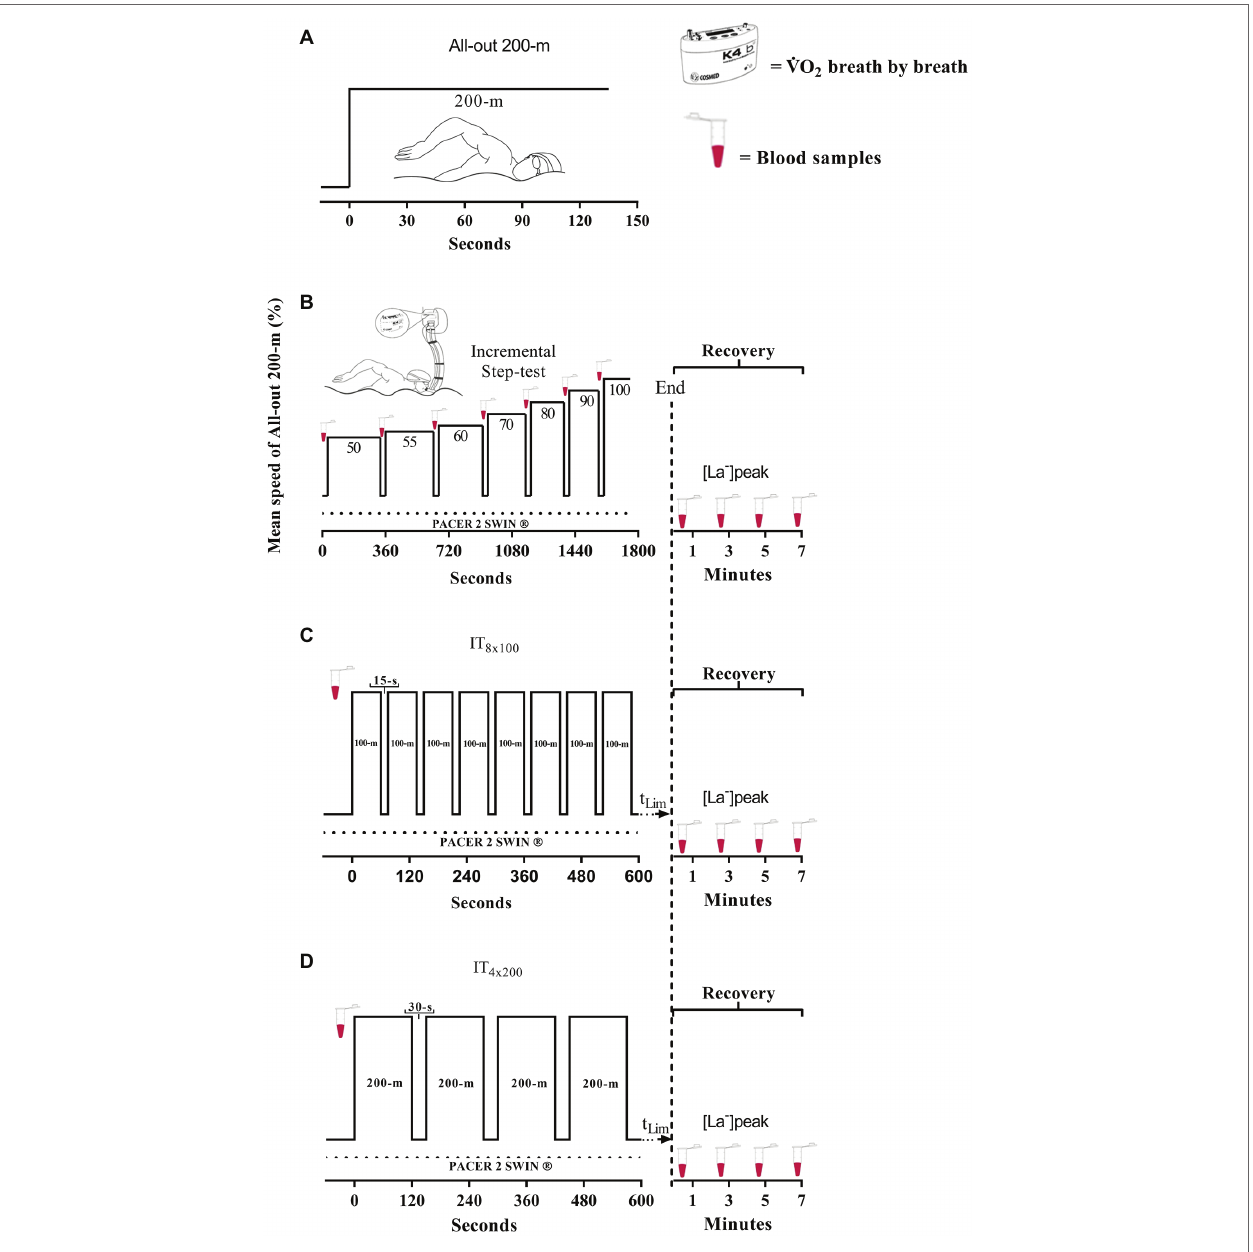
FIGURE 1 | Overview of experimental design for 200-m performance (A) , discontinuous incremental step test (B) , IT 8x100 (C) , and IT 4x200 (D) . The total time limit (t Lim ) indicates n repetitions until exhaustion during IT100 and IT200, respectively (A,B)